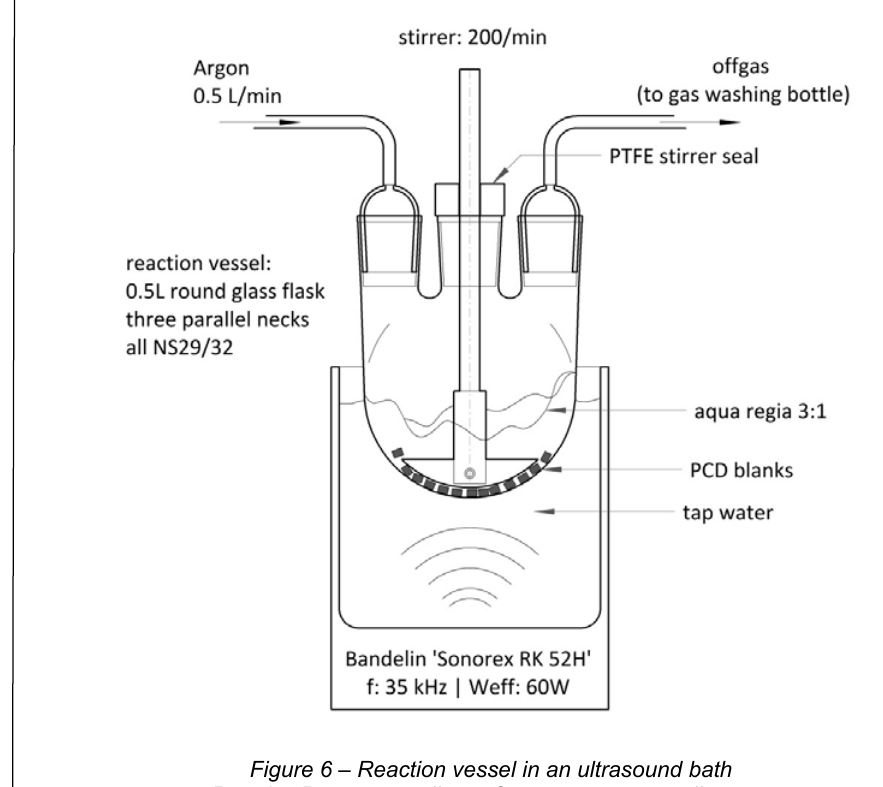
Figure 6 – Reaction vessel in an ultrasound bath Рис . 6 – Реакционный сосуд в ультразвуковой ванне Слика 6 – Реакциони суд у ултразвучном